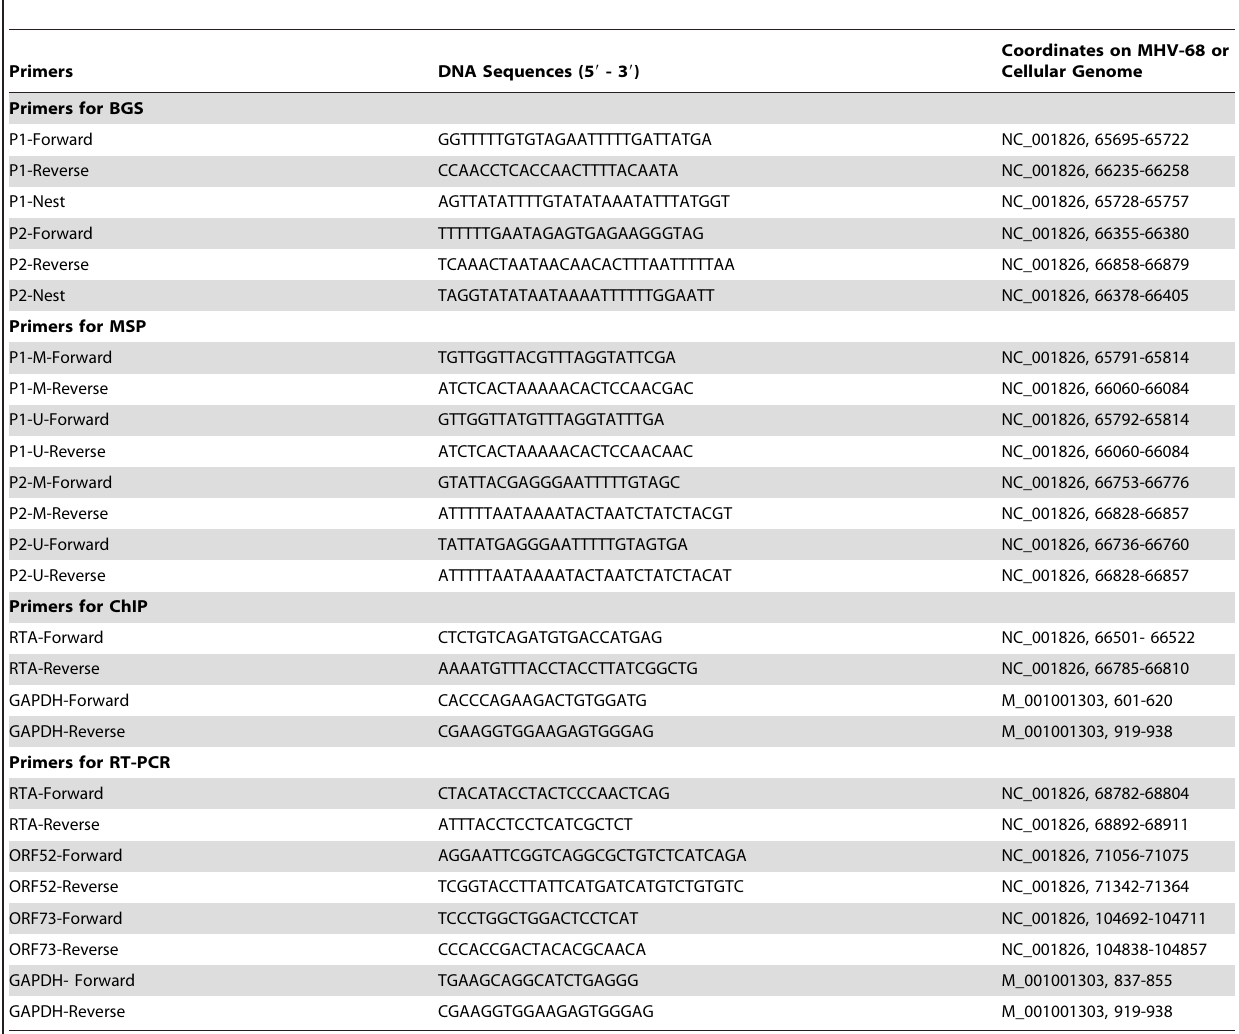
Table 1. Primers used in this study.